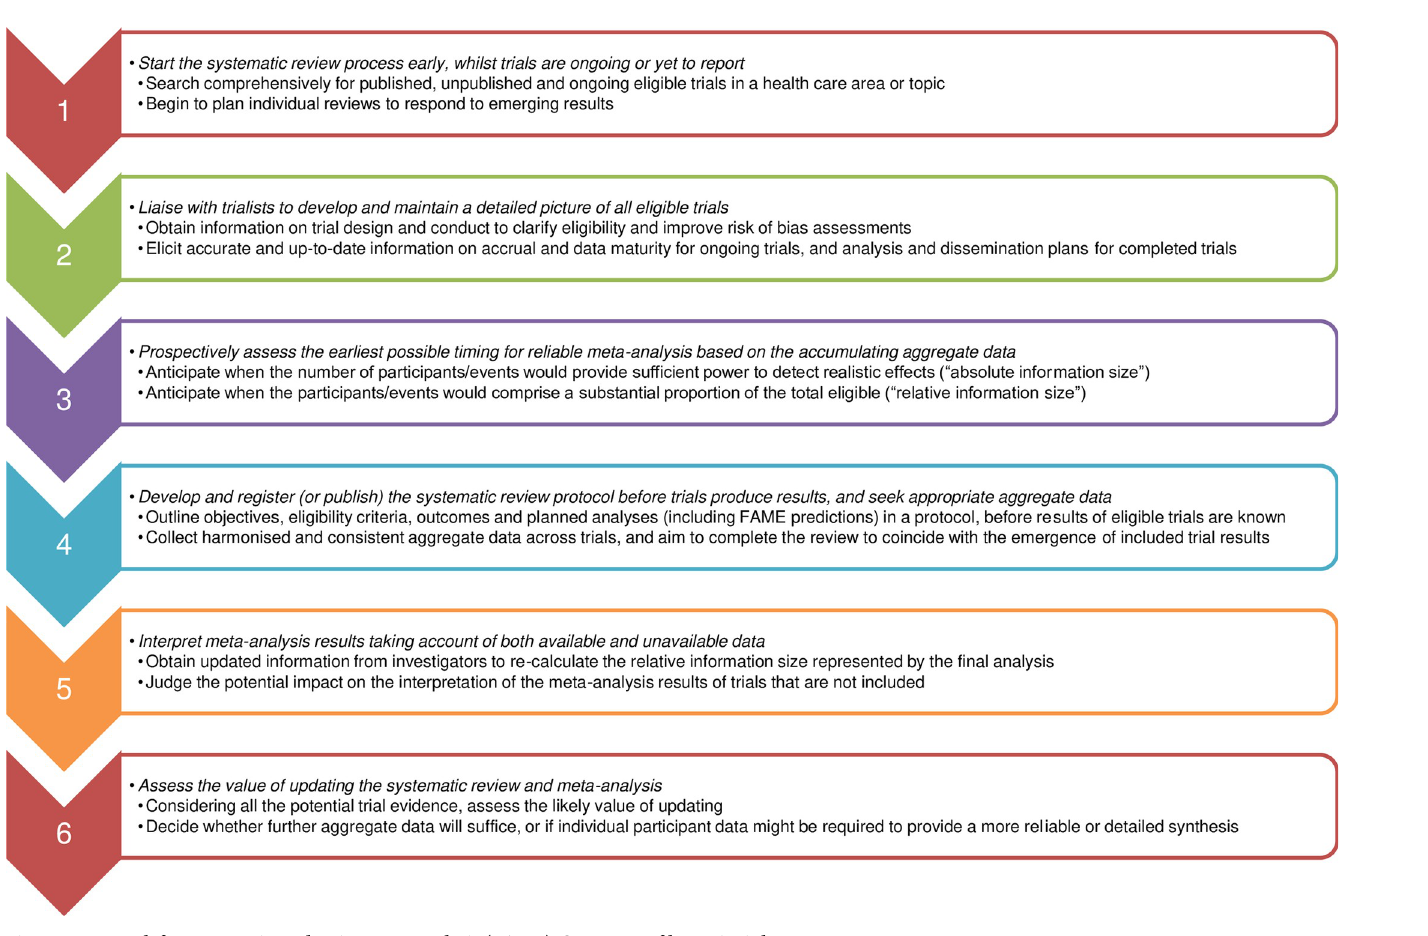
Fig 1. Framework for prospective, adaptive meta-analysis (FAME): Summary of key